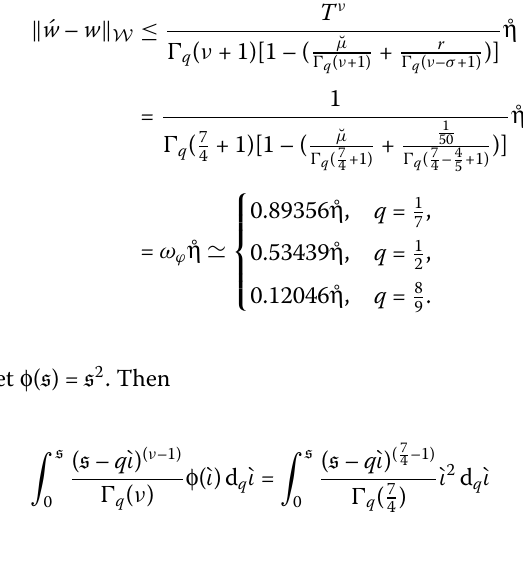
˘ (cid:21) respectively. So by